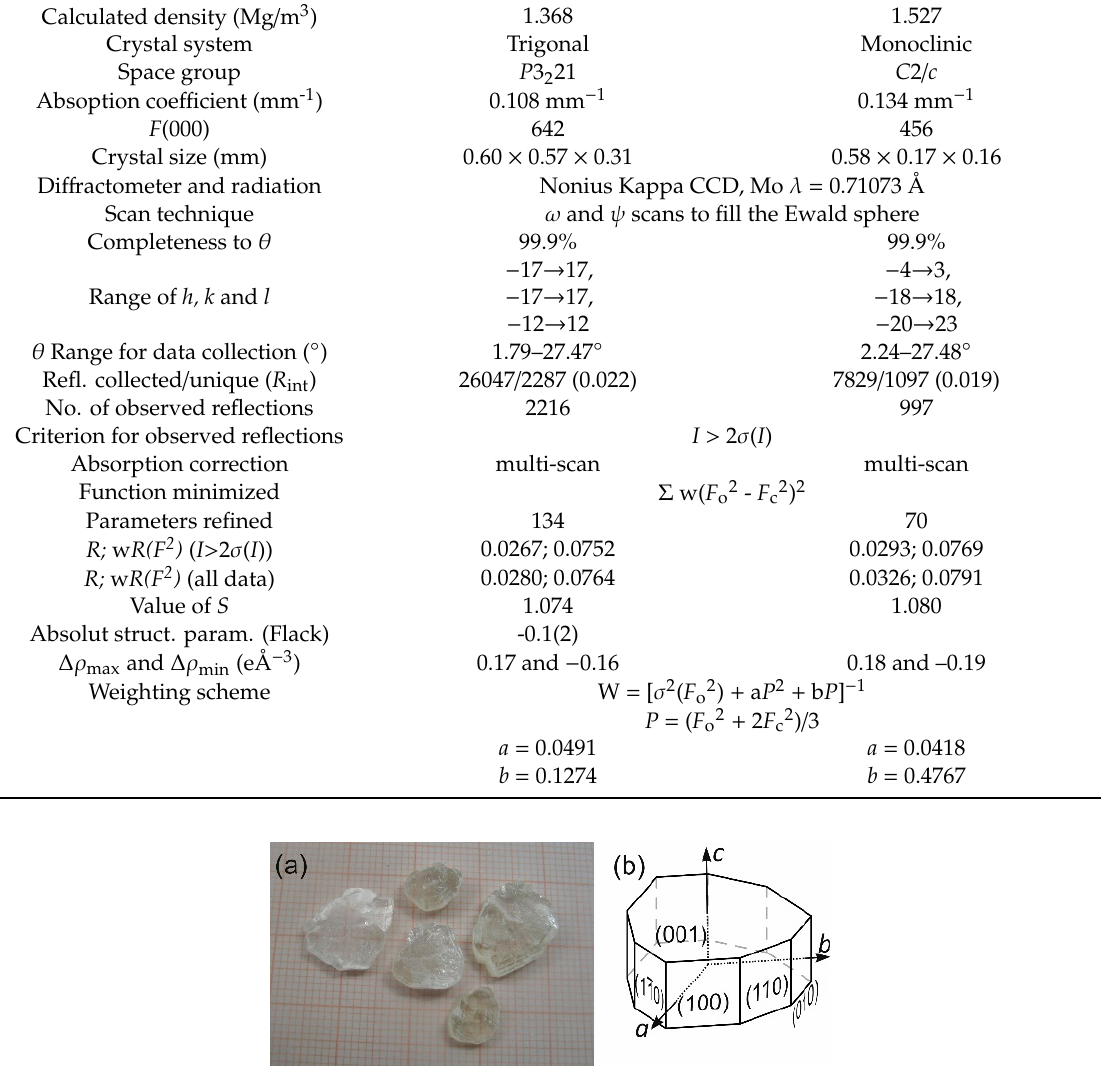
Figure 1. ( a ) Example of cleaved plates of grown crystals of (2-AMP) 3 (H 3 BO 3 ) 2 . ( b ) Typical, idealized morphology of the trigonal crystals of (2-AMP) 3 (H 3 BO 3 ) 2 , shown in